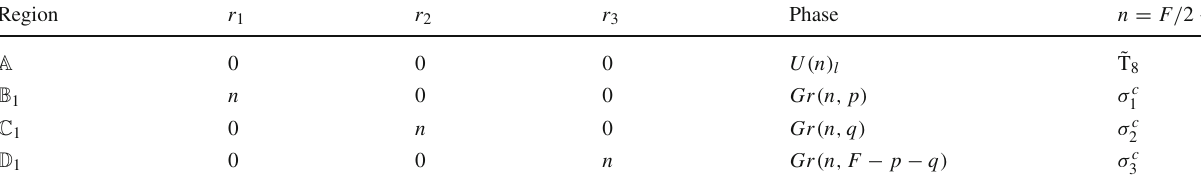
Table 5 Phases of the bosonic theory with n < q ≤ p ≤ F − p − q ≤ F Region r 1 r 2 r 3